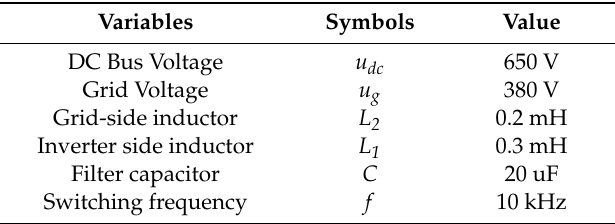
Table 1. Parameters for the system.